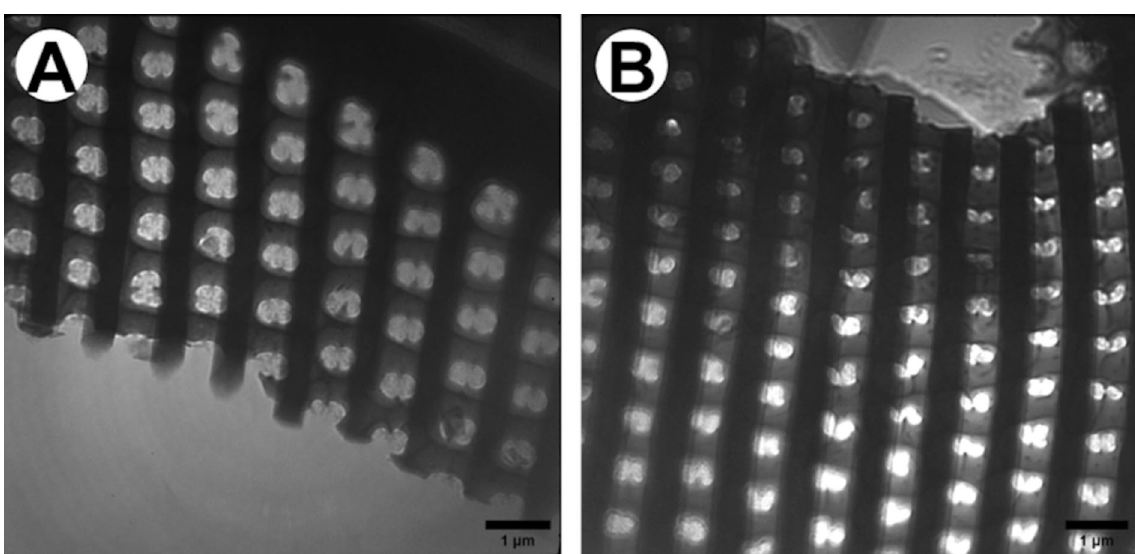
Figure 9. Comparison of the used techniques ( A ) TXM with synchrotron raditation and ( B )